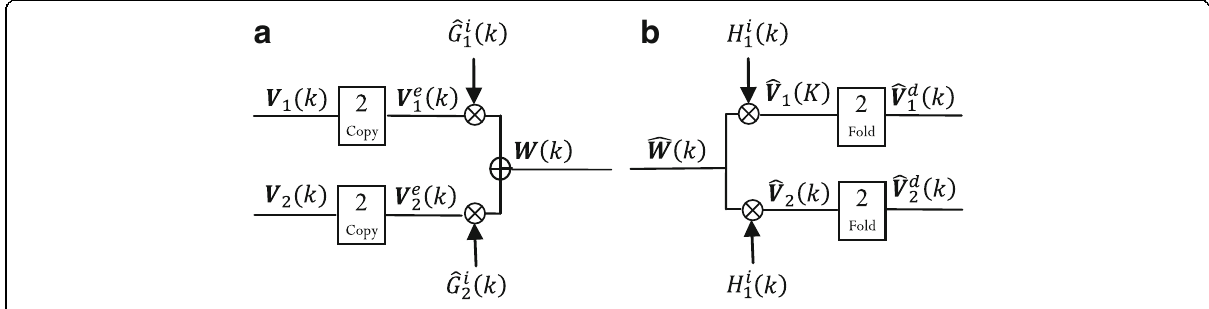
Fig. 6 Two-band a synthesis and b analysis filter bank of i th level of FDTS filter